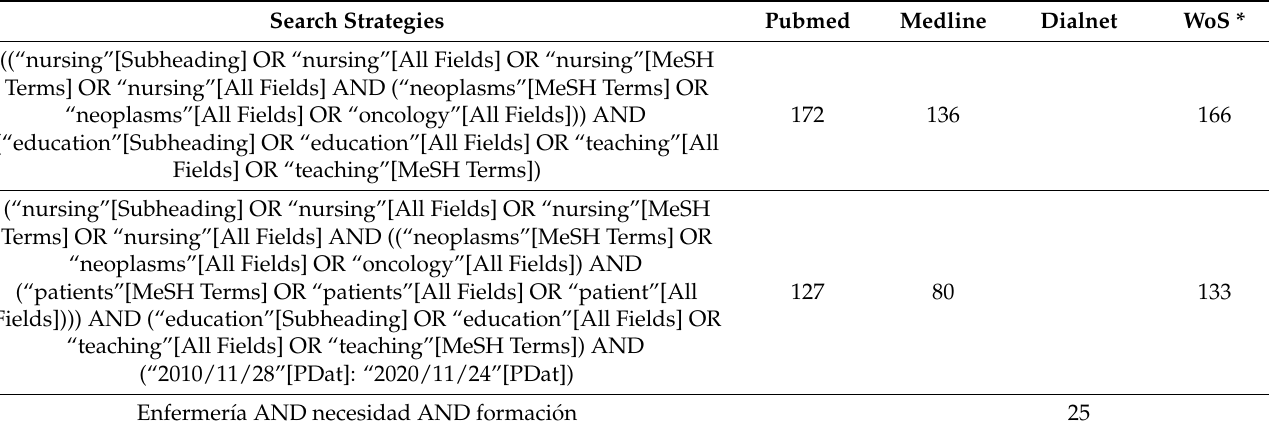
Table 1. Search strategies in the different